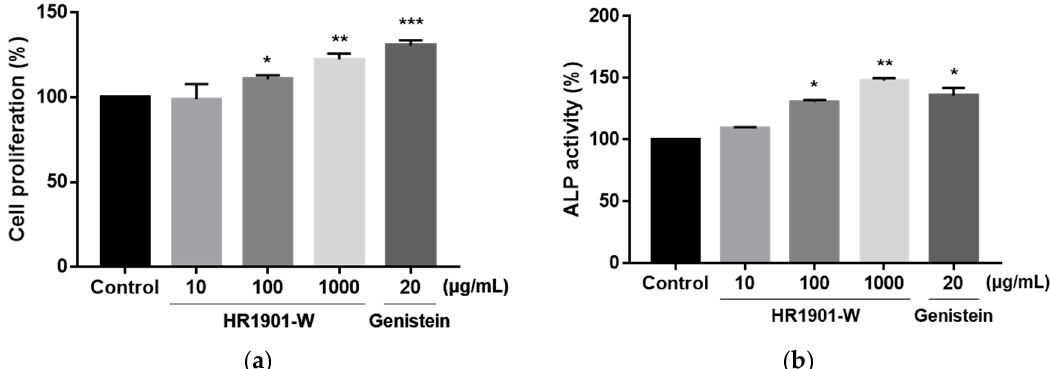
Figure 2. Effects of HR1901-W on the cell proliferation ( a ) and alkaline phosphatase (ALP) activity ( b ) of MC3T3-E1 cells. All values are expressed as the mean ± standard deviation. * p < 0.05, ** p < 0.01, and *** p < 0.001 when compared with the control.